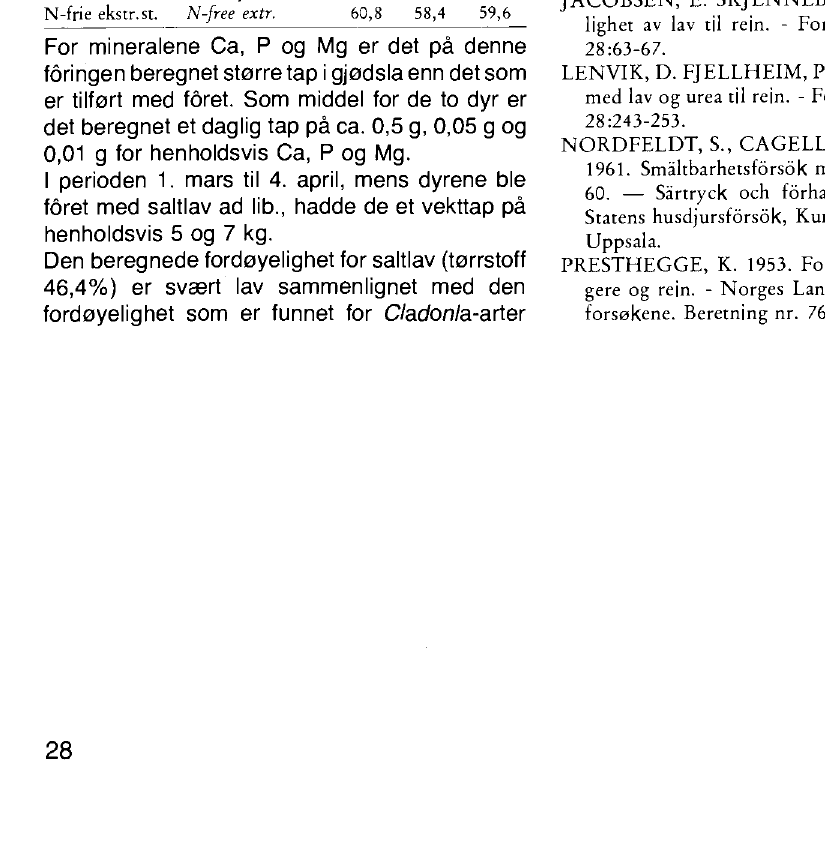
Fordøyelighet % Digestibility